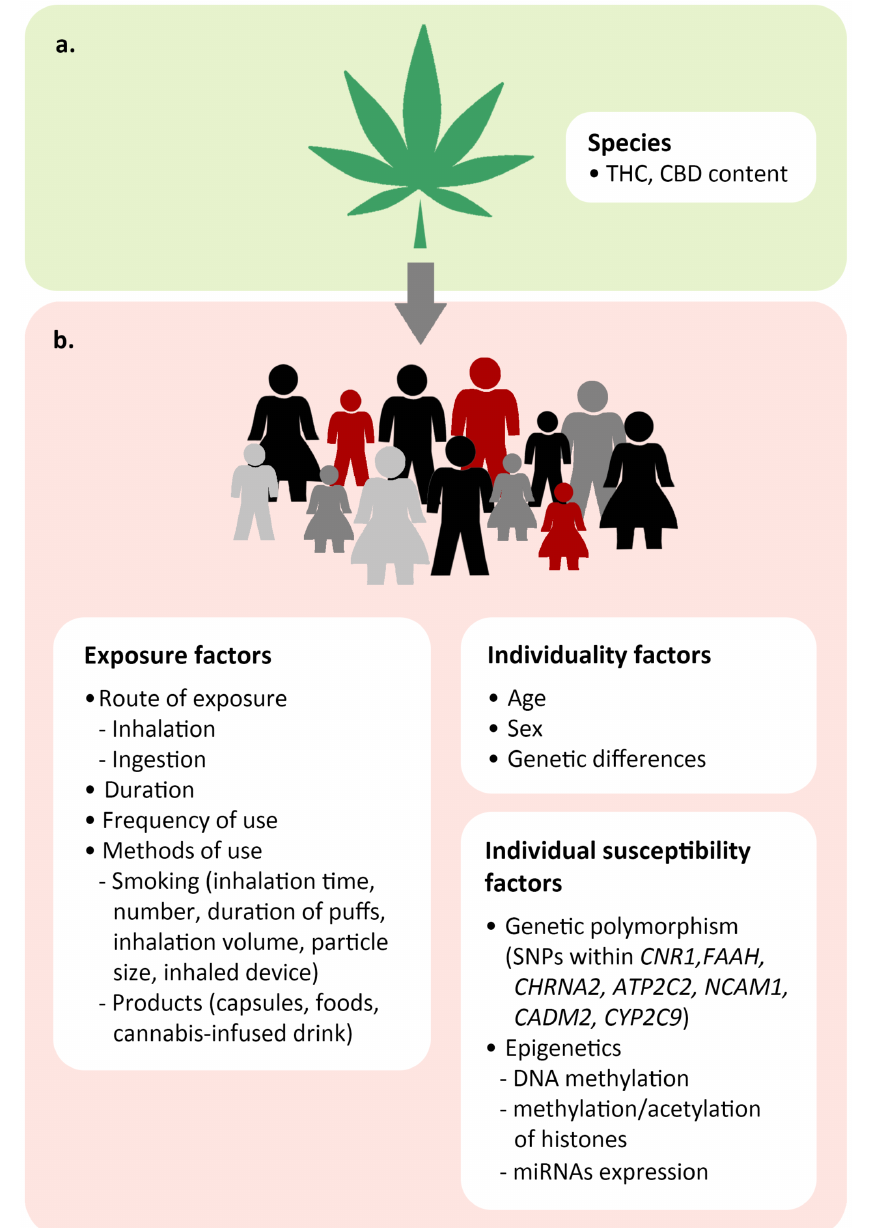
Figure 2. Factors influencing acute and chronic cannabis toxicity in an individual. ( a ) Depending on the species, the amounts of CBD and the psychoactive component THC can vary. ( b ) The toxicity of cannabis depends on exposure factors (route of exposure, duration, frequency, and method of use), individuality factors (age, sex, and genetic differences), and individual susceptibility factors (genetic polymorphism and epigenetics).